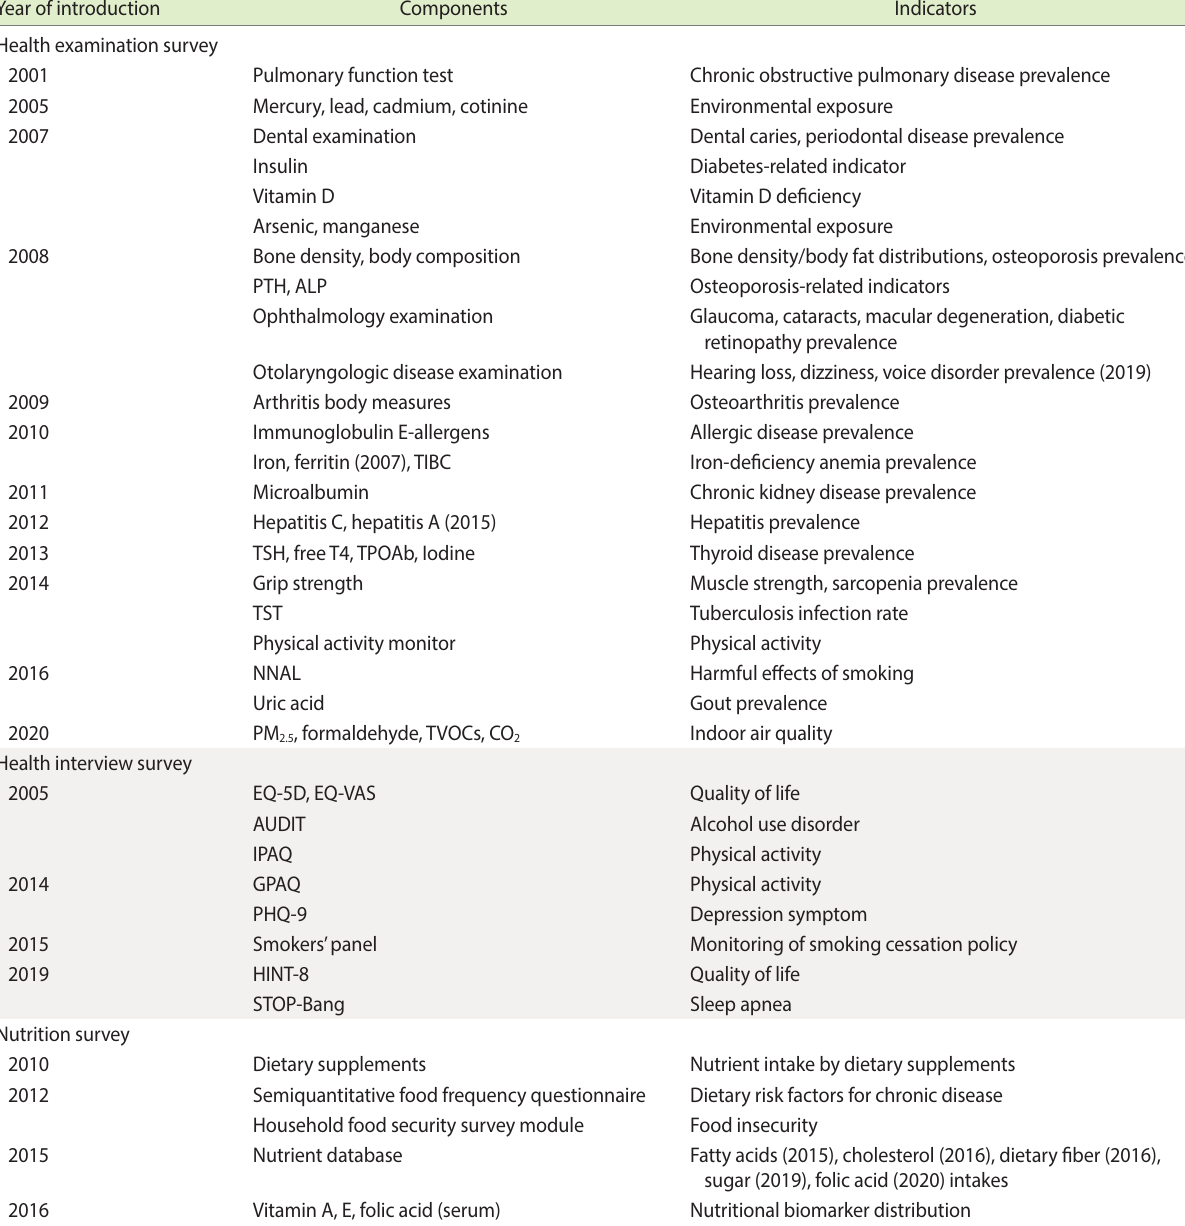
Table 3. Extension of survey components in the Korea National Health and Nutrition Examination